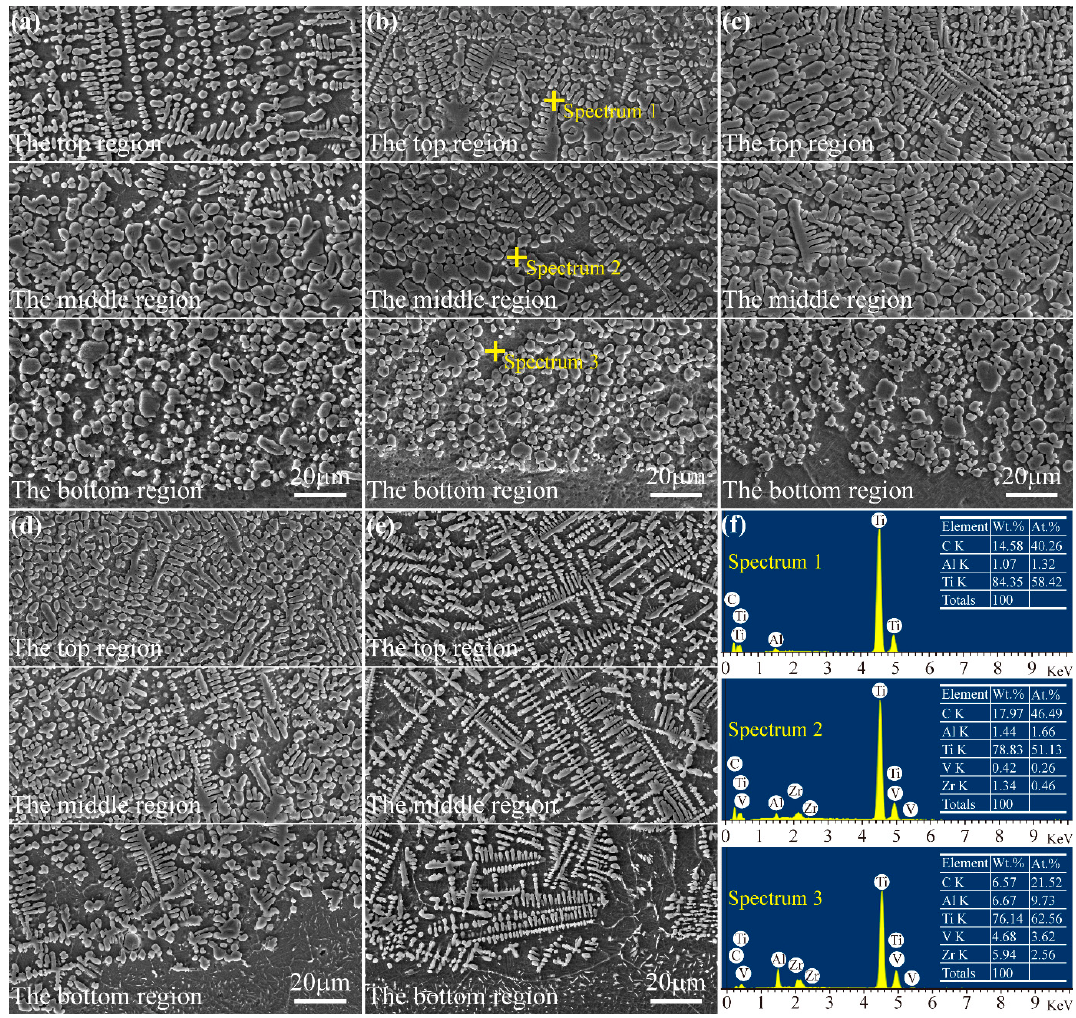
Figure 5. The cross-sectional morphologies of laser-cladding coatings ( a ) without CeO 2 ; ( b ) 1% CeO 2 ; ( c ) 3% CeO 2 ; ( d ) 5% CeO 2 ; ( e ) 7% CeO 2 ; ( f ) corresponding energy-dispersive spectroscopy (EDS) result of a coating with 1% CeO 2 .